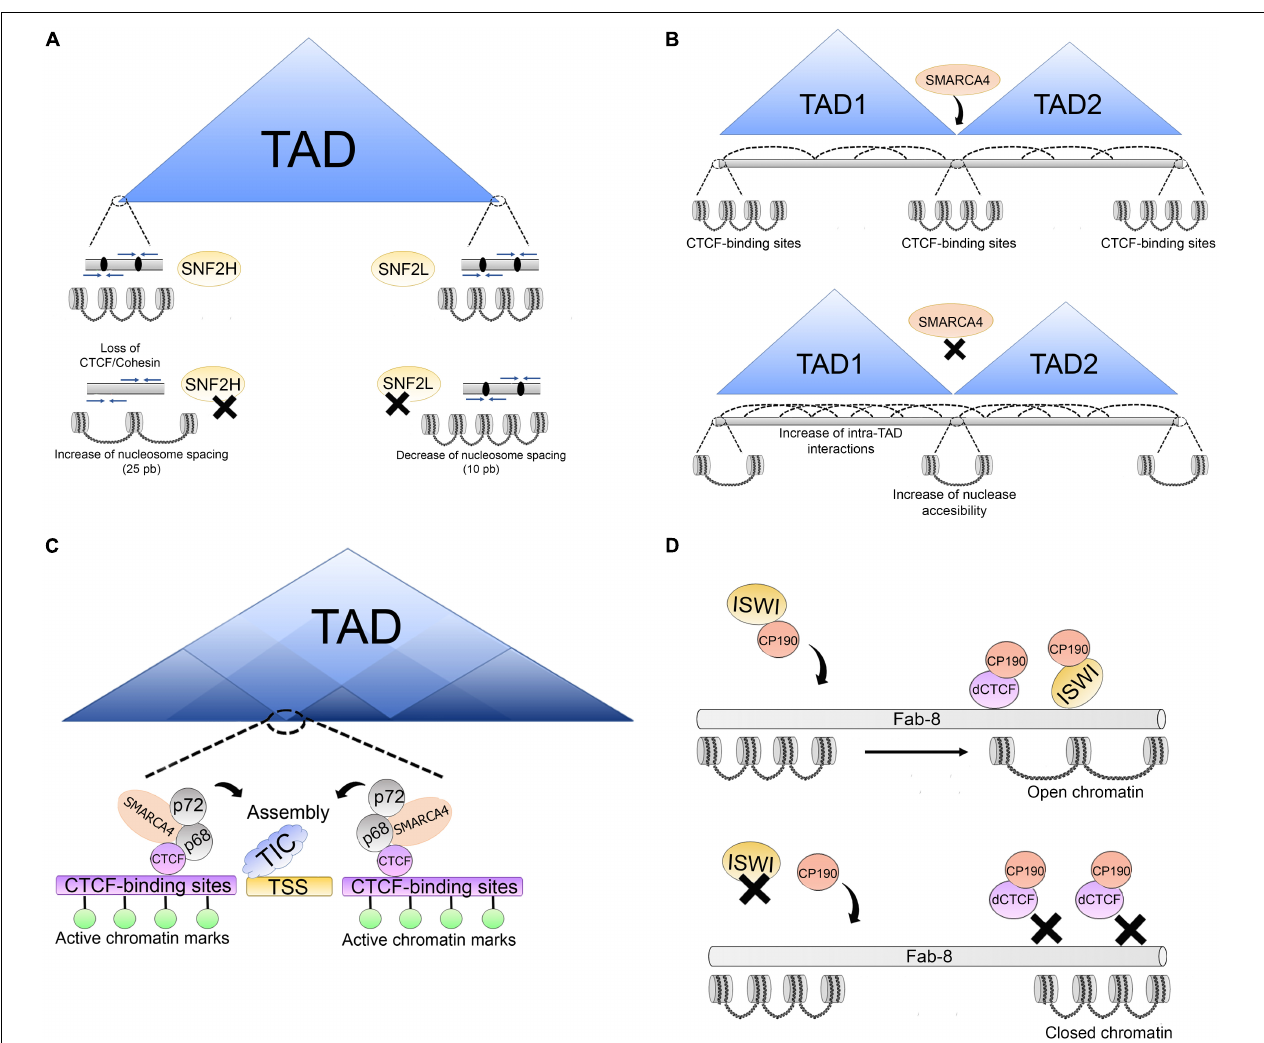
FIGURE 5 | Association of architectural proteins with CRCs in vertebrates. (A) SNF2H and SNF2L are involved in the regulation of nucleosomes at TAD boundaries which are enriched with convergent CTCF binding motifs (blue arrows), CTCF binds and retains the cohesion complex (black ovals). After SNF2H depletion, nucleosome spacing increases over 25 bp promoting loss of CTCF/cohesin complexes. SNF2L depletion alters nucleosome organization of nucleosomes surrounding the CTCF sites and decreases nucleosome spacing over 10 bp. (B) SMARCA4 is a regulator of higher order chromatin structure. Upon SMARCA4 knockdown, weakening of TAD boundaries is triggered increasing intra-TAD and inter-TAD interactions. Additionally, this promotes changes in nucleosome positioning around the CTCF-binding sites, leading to an increase in nuclease accessibility around the CTCF-binding sites. (C) Association between SMARCA4/p68/p72 complex and CTCF. This complex is located on CTCF-binding sites around some TSS enriched with active histone marks. The p66/p72 complex is involved in promoting the assembly of transcription initiation complexes (TIC). The association between SMARCA4/p68/p72 suggests that this complex may be an important CTCF co-factor in chromatin architecture maintenance at some sites which is important for correct transcriptional output. (D) Association of architectural proteins with CRCs in Drosophila . At some insulator sites, as Fab-8, ISWI CRCs (which are directed to these sites by CP190) promote an open chromatin structure at dCTCF-binding sites for insulator function. ISWI depletion alters nucleosome phasing at these sites triggering a closed chromatin state, impairing dCTCF binding and insulator